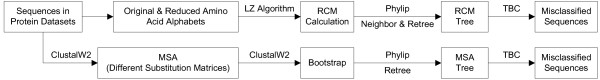
Protocol Overview. For RCM, the original sequences and sequences recoded with reduced alphabets are used to calculate RCM-based distances which are then inputted sequentially to the Neighbor-Joining and Retree programs of the PHYLIP v3.68 package. For MSA, first, alignments are carried out using ClustalW2 with substitution matrices corresponding to each amino acid alphabet. Following bootstrap analysis with ClustalW2, Retree program is used to root the trees with midpoint rooting and to discard branch lengths. Each phylogenetic tree is then inputted to the TBC algorithm along with its attribute file that shows the expert assignment of each sequence to each family to calculate the TBC error.